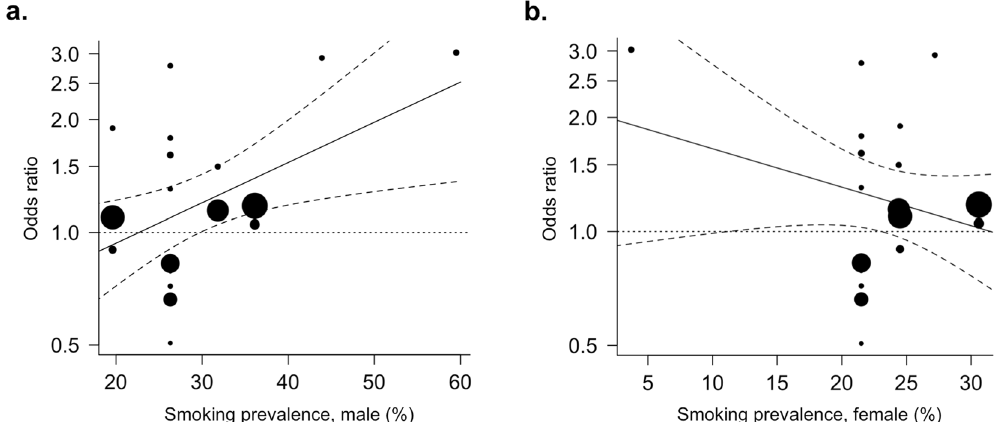
Figure 4. Meta-regression analysis using population smoking metrics as moderators. The OR of ASD with maternal smoking during pregnancy as moderated by ( a ) smoking prevalence in adult males (%) (z = 2.55, p = 0.011), and ( b ) smoking prevalence in adult females (%) (z = − 1.13, p = 0.26) in the country of each study population. The diameters of the circles are proportional to study population size.